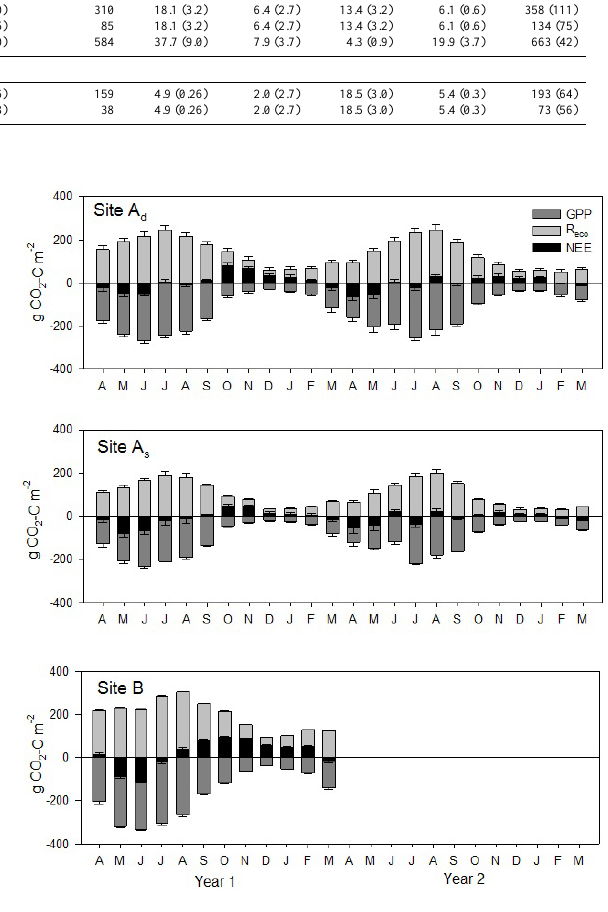
Figure 5. Monthly mean gross primary production (GPP), ecosys- tem respiration ( R eco ) and net ecosystem exchange (NEE) (gCO 2 - Cm − 2 month − 1 ) . Error bars represent ± standard deviation. n = 7 for Site A d , n = 5 for Site A s and n = 9 for Site B. Negative NEE values indicate that the site was a net sink for CO 2 -C for that